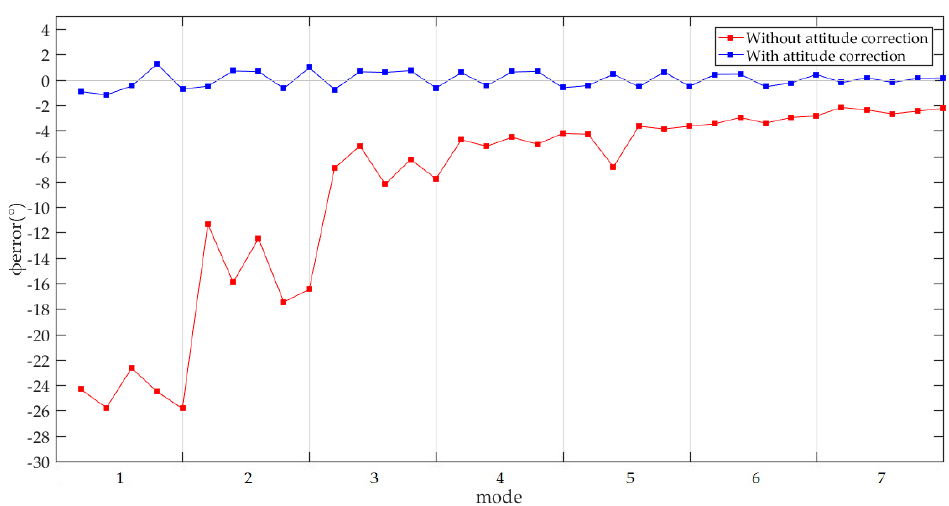
Figure 9. The values of angle φ error of 70 3D point clouds.